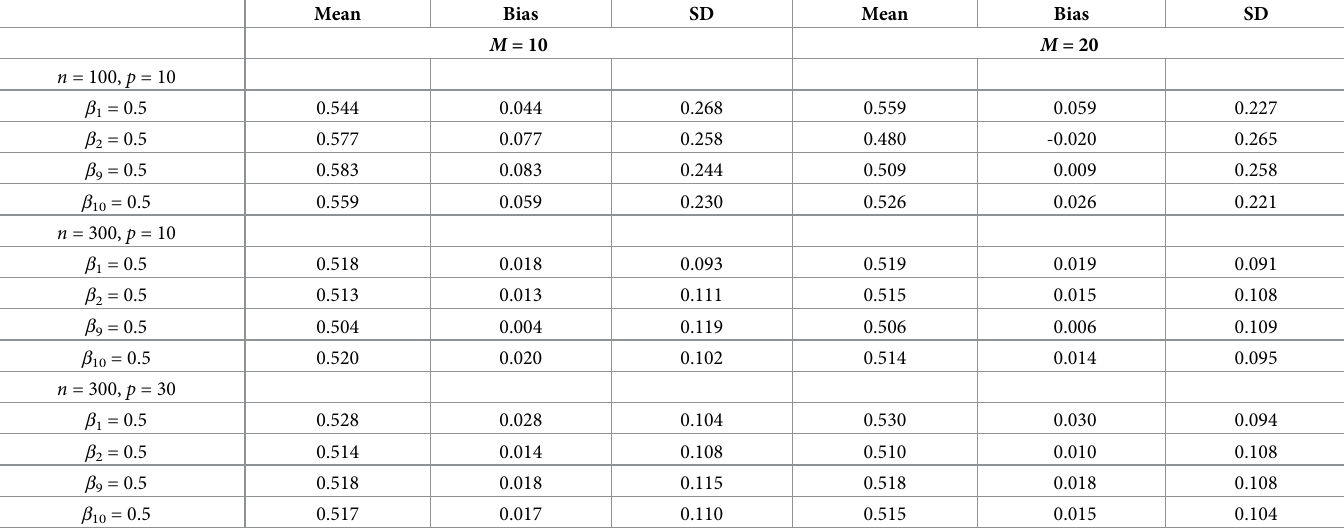
Table 2. Simulation result of appIC sparse estimation with b 0 = 0.5 and baseline cumulative hazards function Λ 0 ( t ) = log ( t + 1).